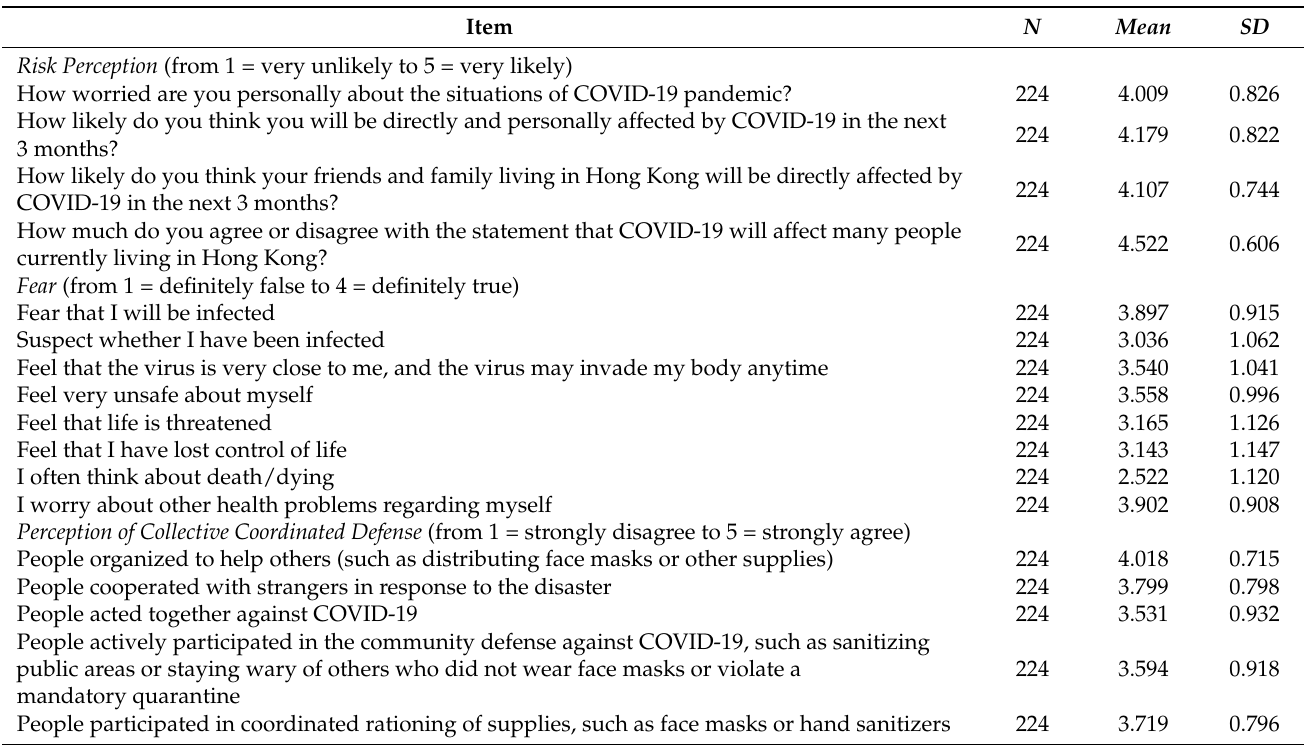
Table 1. Items of COVID-19-related measures and descriptive